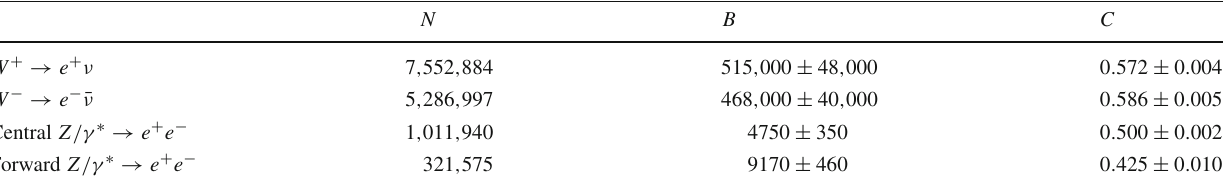
to the estimated yield of multijet events. The sum of all expected back- ground and signal contributions is shown as a solid line with a hashed band detailing the statistical uncertainty and labelled “total (stat)”. The legend lists only background sources with a visible contribution background to the W ± channels stems from the W → τν contribution, which is proportional to the signal yield. The given uncertainties are the sum in quadrature of statistical and systematic components. The statistical uncertainties in C are negligible